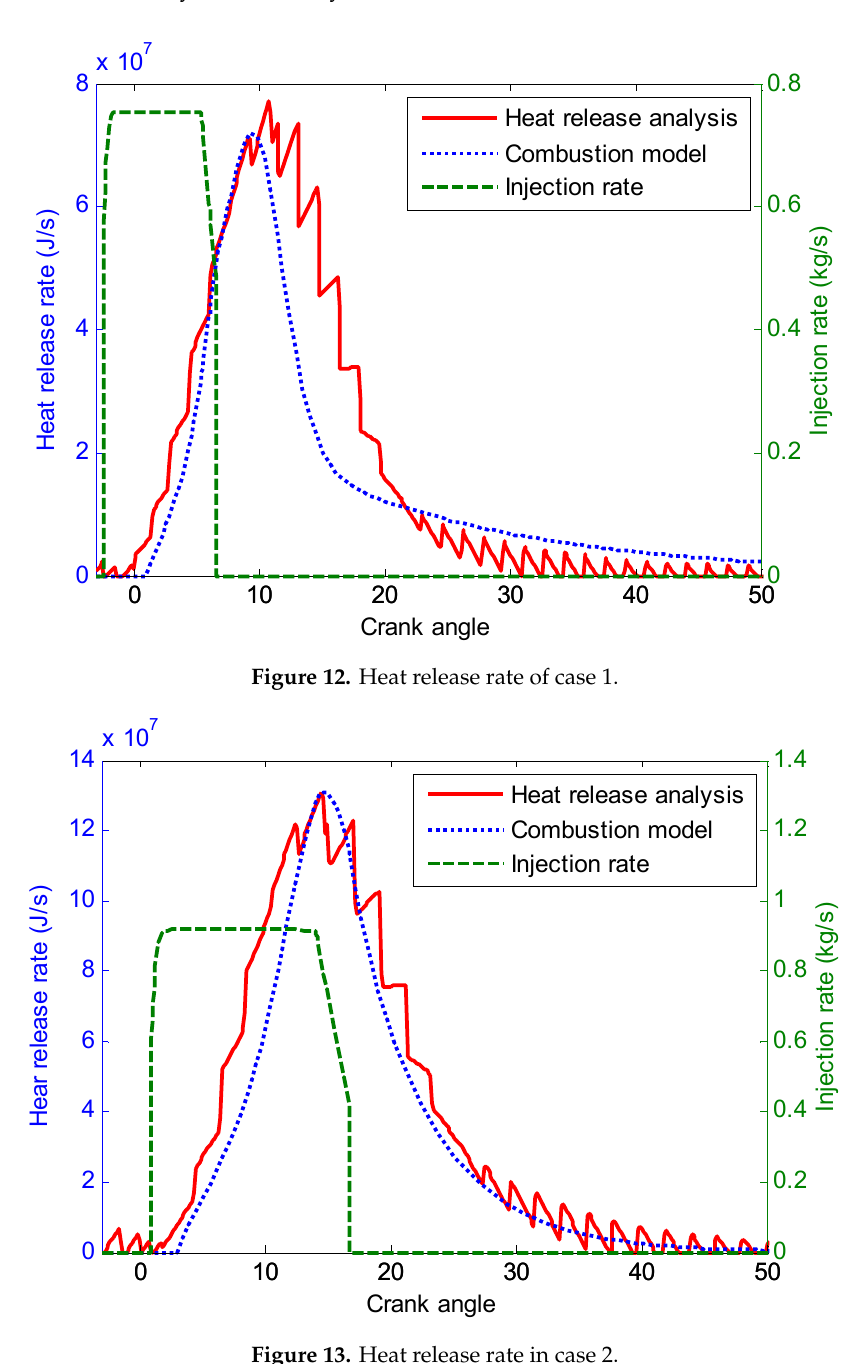
Figure 14. Simulink model for the combustion model.